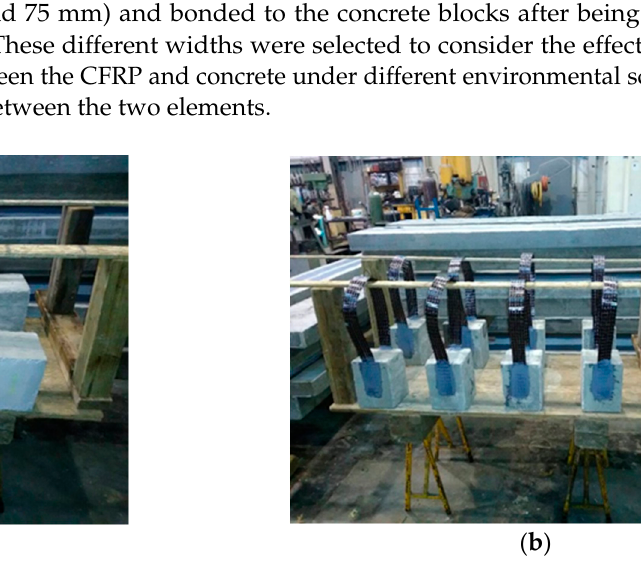
Figure 1. Preparation of specimens. ( a ) Rectangular concrete prisms. ( b ) The CFRP bonded to the concrete blocks. concrete